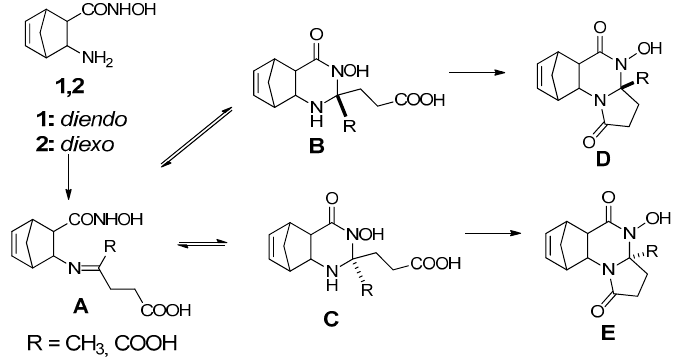
Scheme 1. The domino reaction pathway.